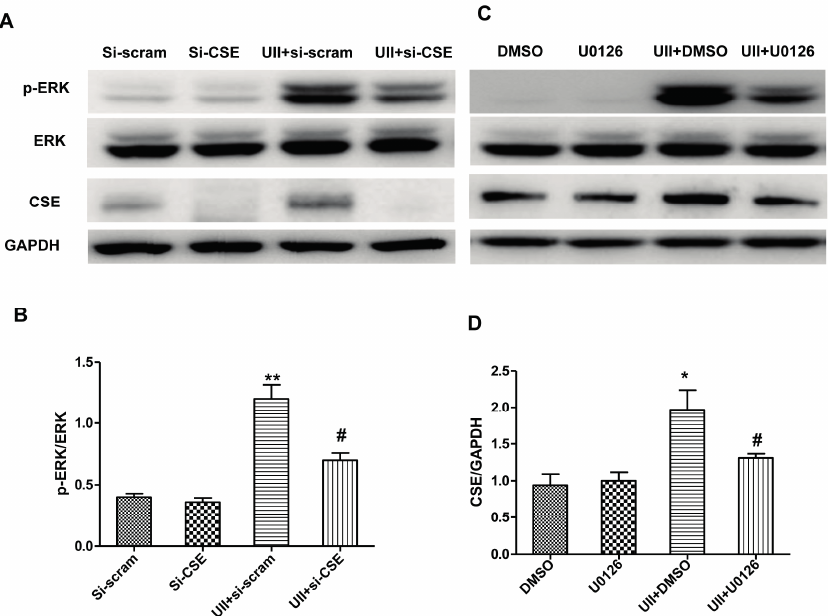
Figure 4. UII induces the reciprocal regulation of CSE and ERK in cardiomyocytes exposed to H 2 O 2 . Representative image of p-ERK, ERK, CSE ( A ) and quantitative analysis of p-ERK/ERK level ( B ) by Western blot analysis in cultured cardiomyocytes. Cardiomyocytes were transfected with si-scramble or si-CSE for 48 h, treated with UII (0.1 μ M) or PBS for 30 min, then exposed to 100 μ M H 2 O 2 for 10 min, analyzed for p-ERK and ERK levels, or exposed to 100 μ M H 2 O 2 for 24 h, and analyzed for CSE level. Values are mean ± SEM. ** p < 0.01, UII + si-scram vs. Si-scram or UII + si-CSE vs. Si-CSE. # p < 0.05, UII + si-CSE vs. UII + si-scram. Representative image of p-ERK, ERK, CSE ( C ) and quantitative analysis of p-ERK/ERK level ( D ) by Western blot analysis in cultured cardiomyocytes. Cultured cardiomyocytes were treated with DMSO or U0126 with or without UII for 30 min, then exposed to 100 μ M H 2 O 2 for 10 min, analyzed for p-ERK and ERK level, or exposed to 100 μ M H 2 O 2 for 24 h, and analyzed for CSE level. Values are mean ± SEM. * p < 0.05, UII + DMSO vs. DMSO or UII + U0126 vs. UII + DMSO. # p < 0.05, UII + U0126 vs. UII + DMSO. All experiments were repeated independently at least three